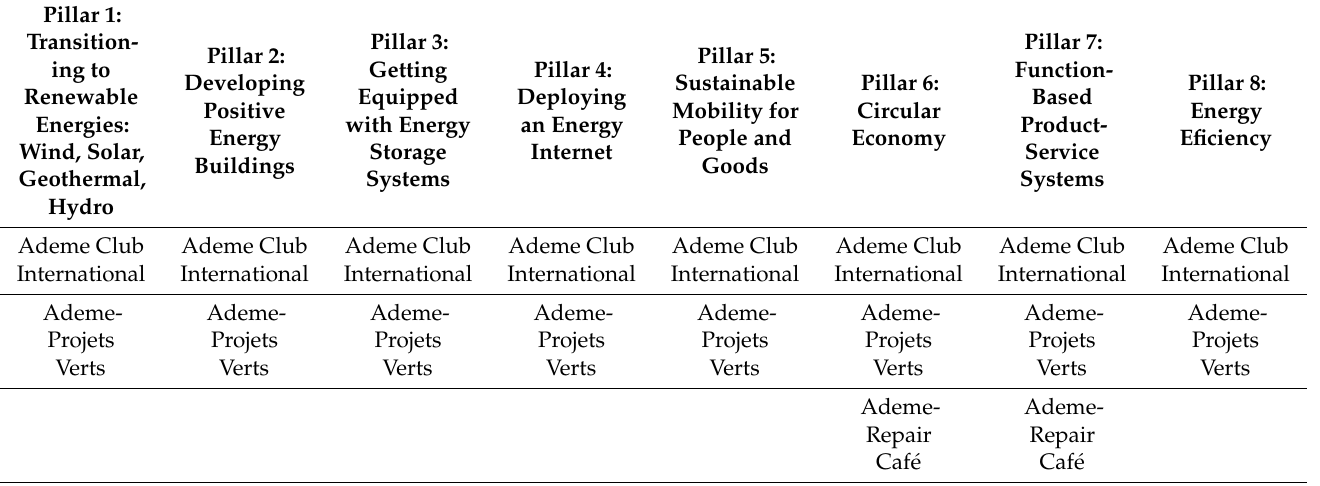
Table A1. Breakdown of sources by